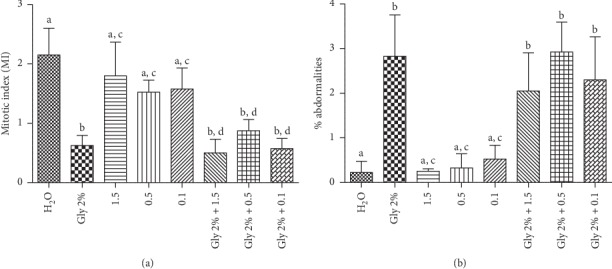
(a) Mitotic Index (MI) and (b) Percentage of Abnormalities (AN) for C. nutans leaf obtained in the Allium cepa assay. Different letters represent statistical differences according to the Tukey test (<0.001).